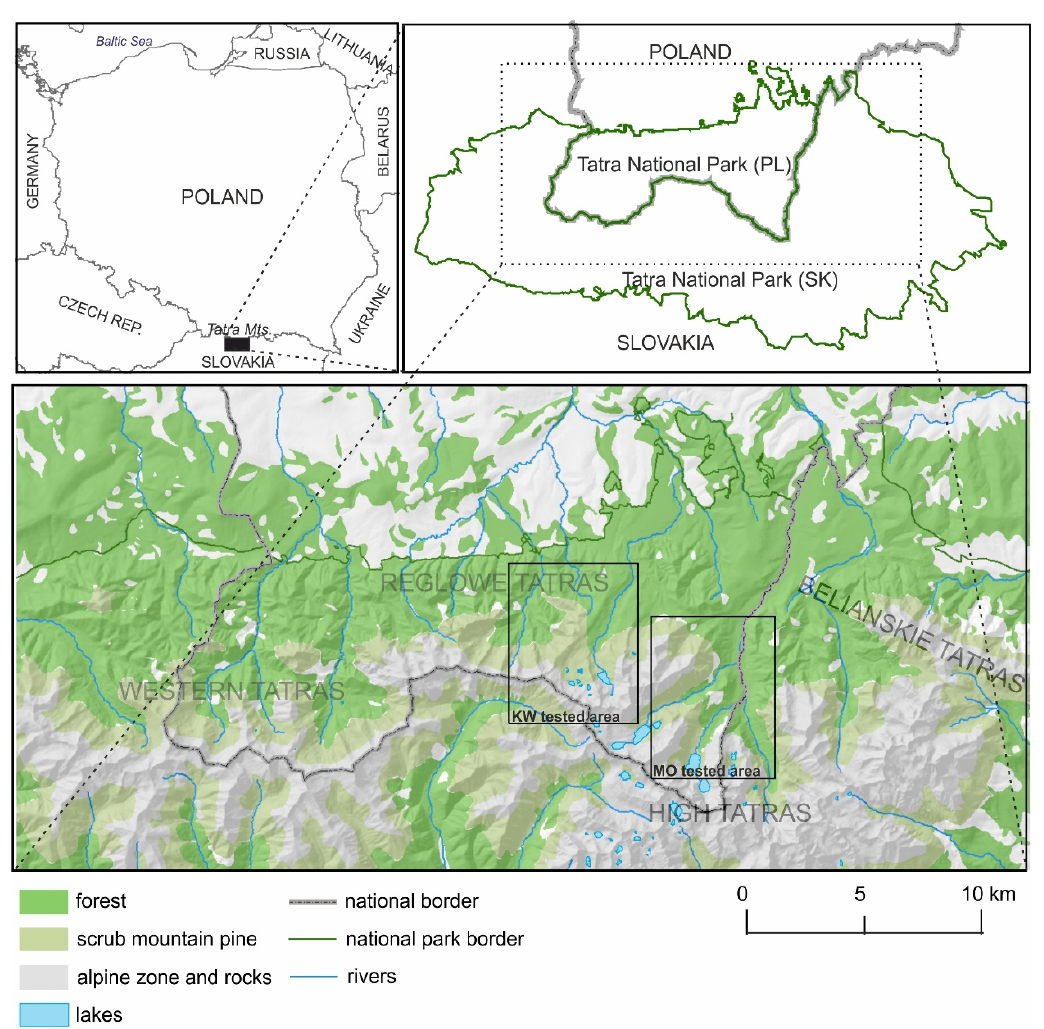
Figure 1. Location of the tested area on the background of the map of Poland and Tatra National Park.